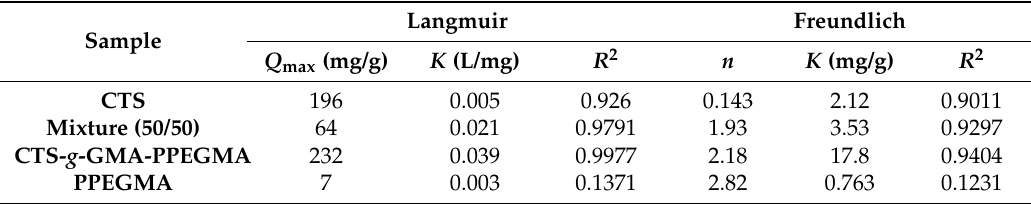
Table 1. Langmuir and Freundlich Isotherm constants.